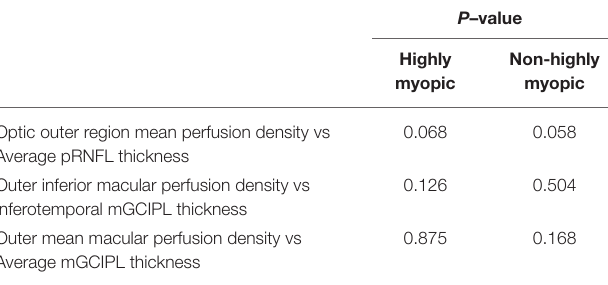
TABLE 4 | Comparisons of AUCs of the vessel perfusion density parameters and structural